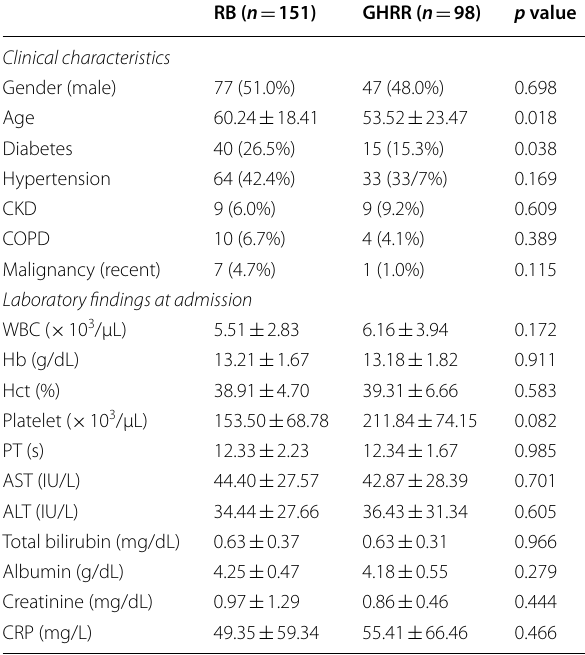
Table 1 Baseline clinical characteristics and laboratory findings